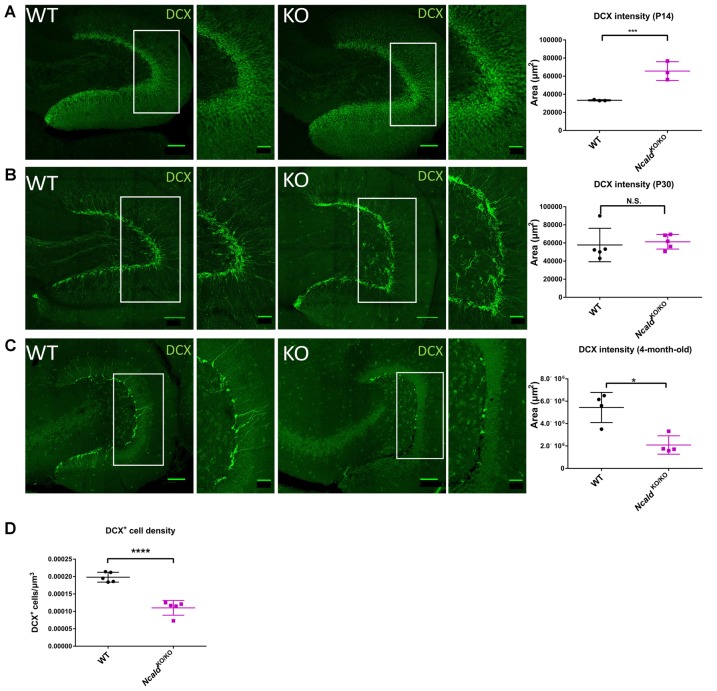
Disturbed adult neurogenesis in the hippocampus of NcaldKO/KO mice. (A) Immunofluorescent analysis of doublecortin (DCX) positive neurons in the DG of P14 WT and NcaldKO/KO animals; scale bars 100 μm and 40 μm (magnified insert); N = 3; ***P < 0.005. (B) Immunofluorescent analysis of DCX+ neurons in the DG of WT and NcaldKO/KO animals at P30; scale bars 100 μm and 40 μm (magnified insert); N = 5; N.S. = not significant. (C) Immunofluorescent analysis of DCX+ neurons in the DG of 4-month-old WT and NcaldKO/KO animals. DCX intensity is significantly lower in mice deficient for NCLAD; scale bar 100 μm and 40 μm (magnified inset); N = 5; *P < 0.05. (D) Dot plot analysis indicating a significant decrease in the DCX+ cell density in 4-month-old NcaldKO/KO animals compared to WT controls; N = 5; ****P < 0.0001.